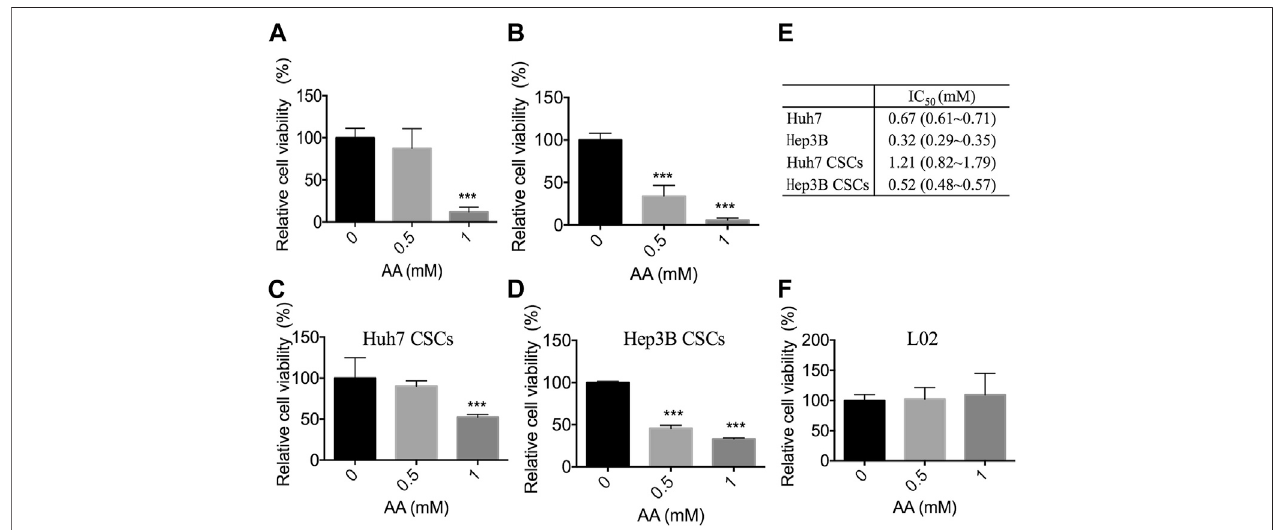
FIGURE 1 | Inhibitory effects of AA on the viability of liver cancer cells in vitro . Cells were treated with AA at the concentration as shown and cell viability was measuredbyCCK-8assay. (A) CellviabilityofHuh7cells. (B) CellviabilityofHep3Bcells. (C) CellviabilityofHuh7CSCs. (D) CellviabilityofHep3BCSCs. (E) IC50values of AA, values are mean and 95% con fi dence. (F) Cell viability of L02 hepatocytes. *** p < 0.001.